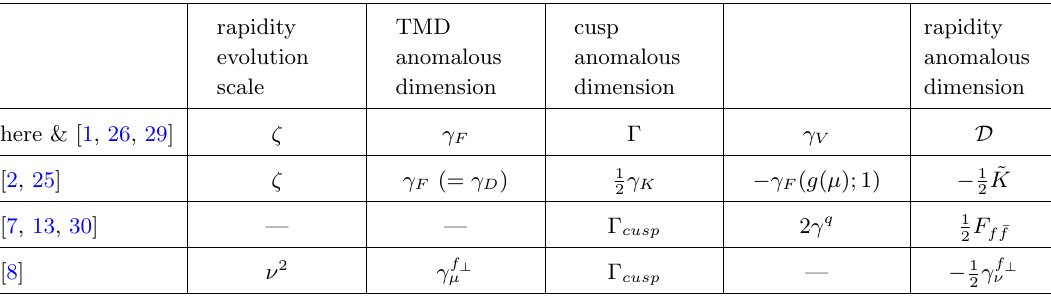
Table 1 . Correspondence of notation for TMD anomalous dimensions used here to some other popular